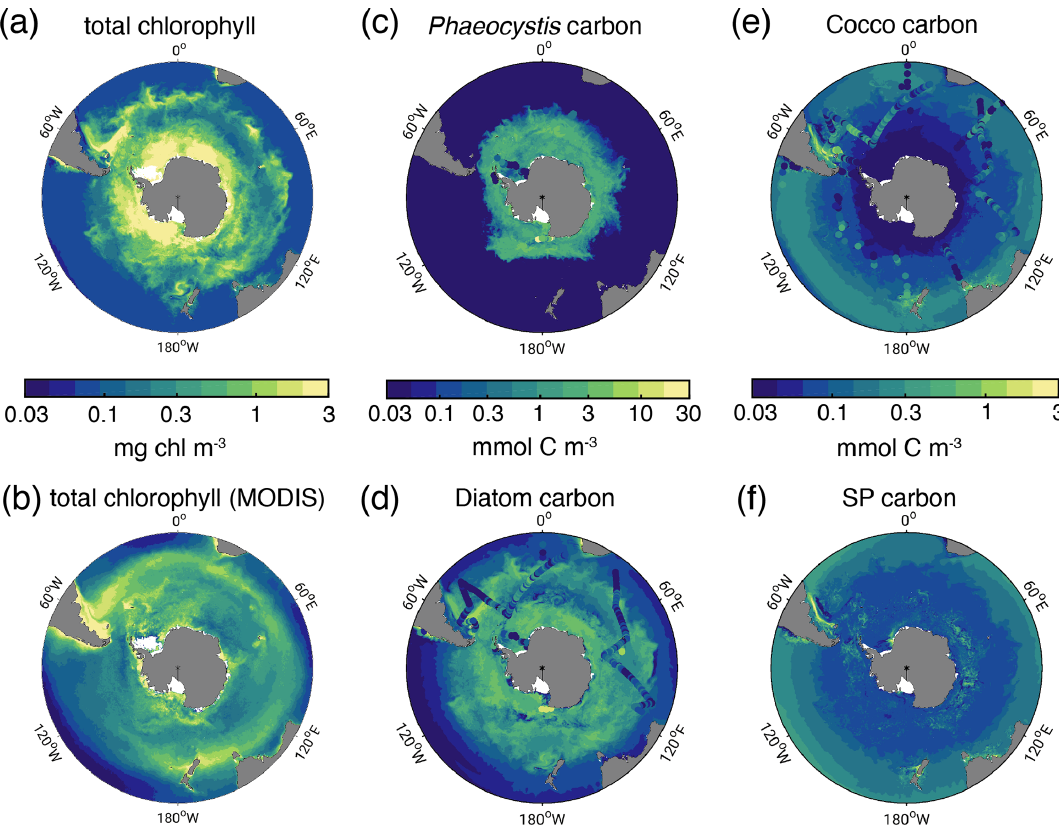
Figure 1. Biomass distributions for December–March (DJFM). Total surface chlorophyll (mgchlm − 3 ) in (a) ROMS-BEC and (b) MODIS- Aqua climatology (NASA-OBPG, 2014a) using the chlorophyll algorithm by Johnson et al. (2013). (c, f) Mean top 50m (c) Phaeocystis , (d) diatom, (e) coccolithophore, and (f) small phytoplankton carbon biomass concentrations (mmolCm − 3 ) in ROMS-BEC. Phaeocystis , diatom, and coccolithophore biomass observations from the top 50m are indicated by colored dots in (c) , (d) , and (e) , respectively (Balch et al., 2016; Saavedra-Pellitero et al., 2014; O’Brien et al., 2013; Vogt et al., 2012; Leblanc et al., 2012; Tyrrell and Charalampopoulou,